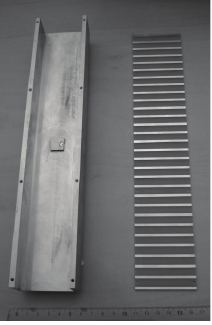
Figure 2: Sectoral EBG antenna structure.